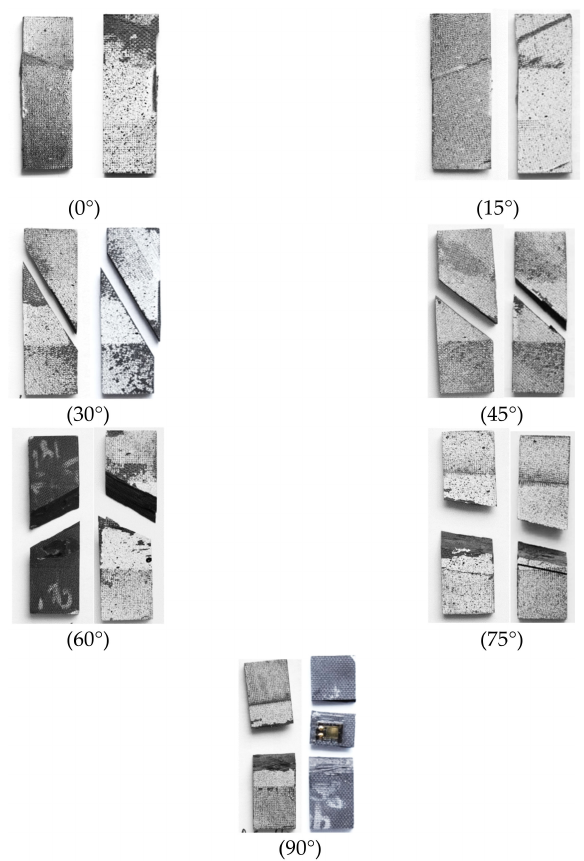
Figure 3. The failure modes of different specimens under compressive